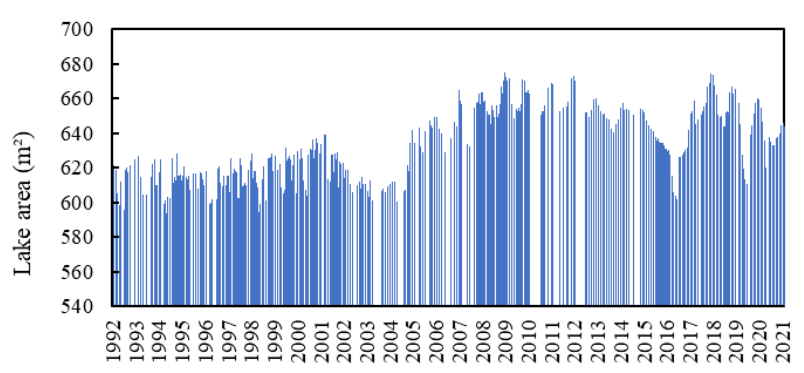
Figure 9. Surface area change trend of Ngoring Lake during the period